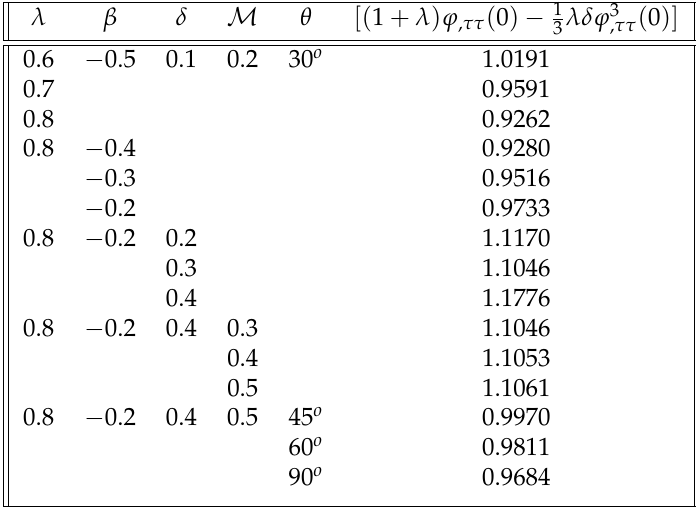
Table 3. Skin friction coefficient vs. those geometric and physical